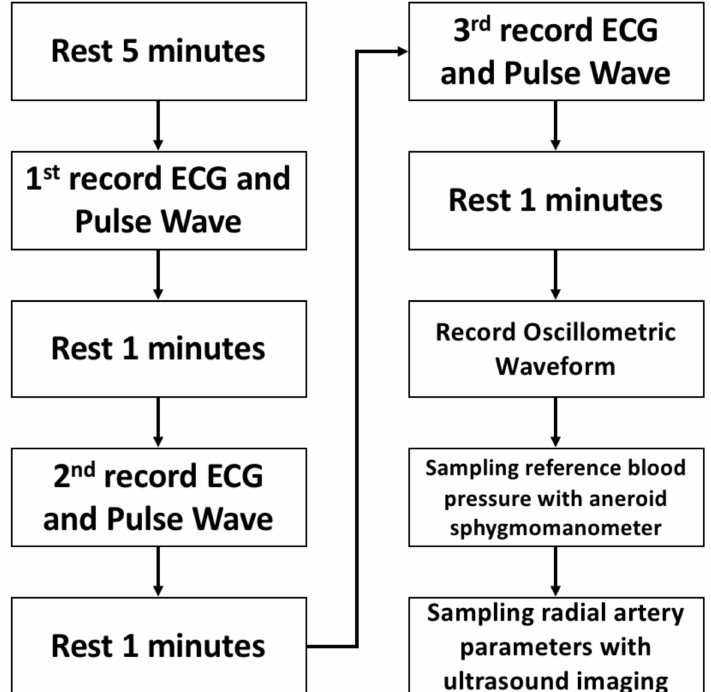
Figure 13. Experimental protocol.